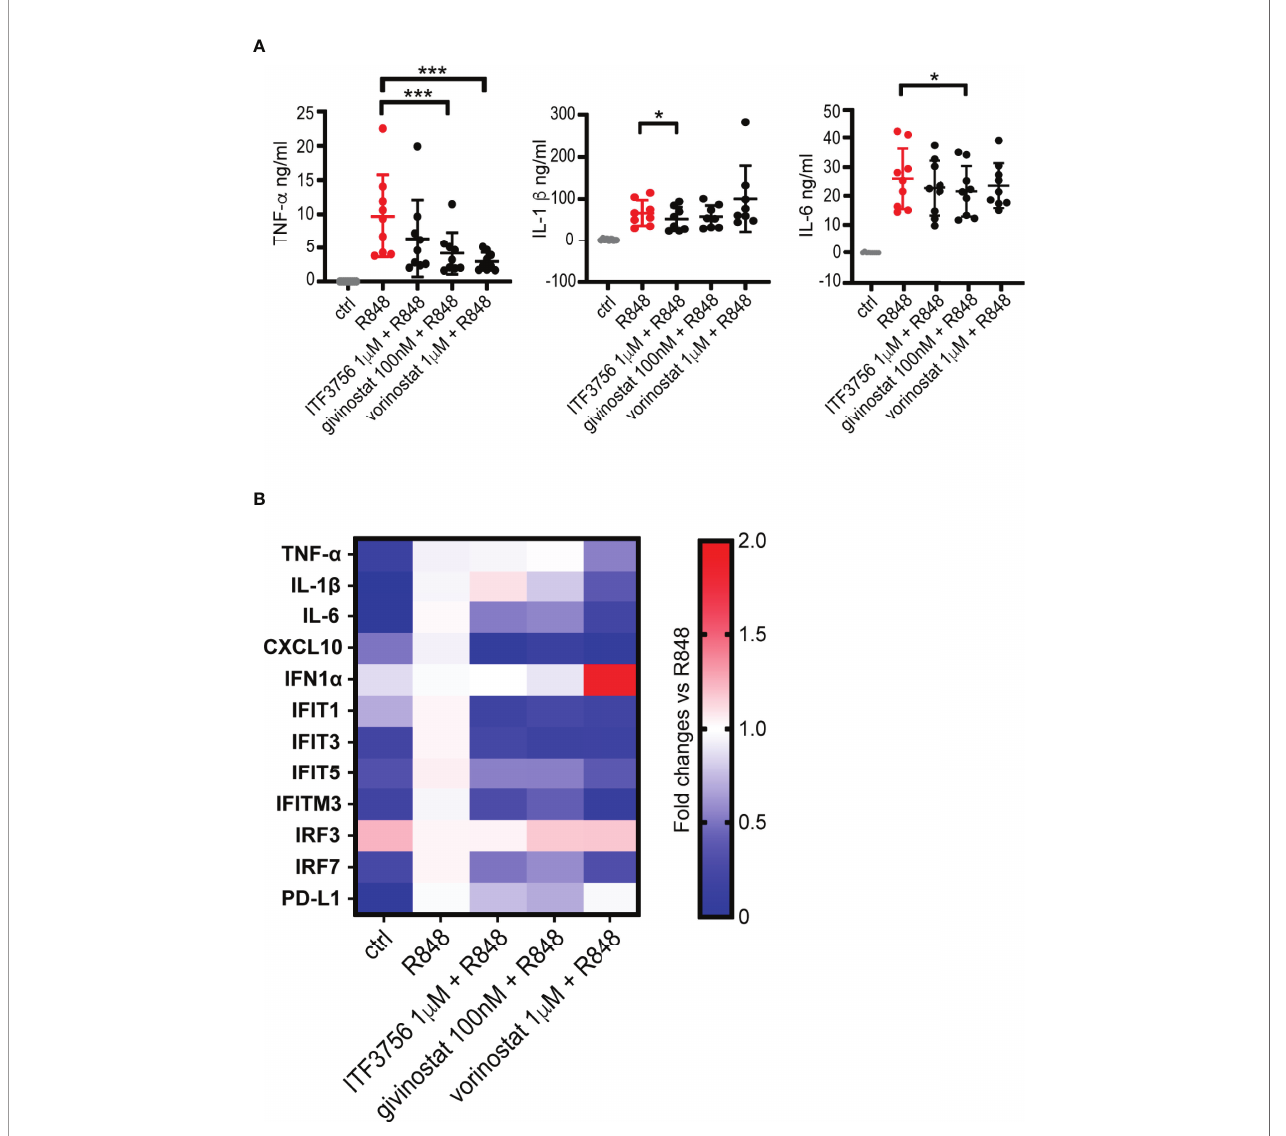
FIGURE 5 | HDACi decrease pro-in fl ammatory cytokines production and gene expression in R848-stimulated macrophages. Human macrophages, differentiated from monocytes, were pre-treated with HDACi and stimulated with R848 (5 m g/ml) ON. After incubation, supernatants were collected for ELISA analysis while cells were harvested for gene expression analysis by qPCR. (A) TNF- a , IL-1 b and IL-6 ELISA. Values on the graphs represent the mean± SD values of at least 8 different donors. P values were calculated by RM one-way ANOVA followed as described in material and methods. ***p < 0.001. (B) Gene expression analysis by qPCR. Values on the graphs represent the mean± SD values obtained from 4 different